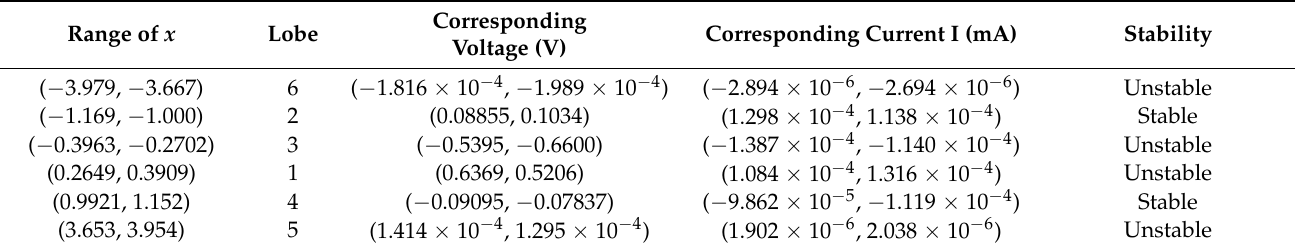
Table 1. Locally active regions of the